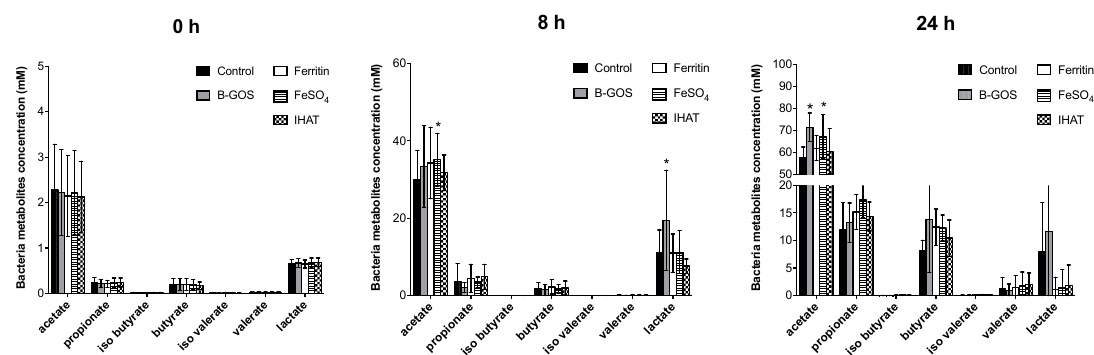
Figure 6. SCFA production at baseline (0 h), 8 and 24 h of fermentation in pH-controlled batch cultures inoculated with faeces from healthy adult donors. Values are mean ± SD of five independent experiments (five donors). *, significant differences from the control condition (i.e., gut model media only, with no additional test substrate), p < 0.05.